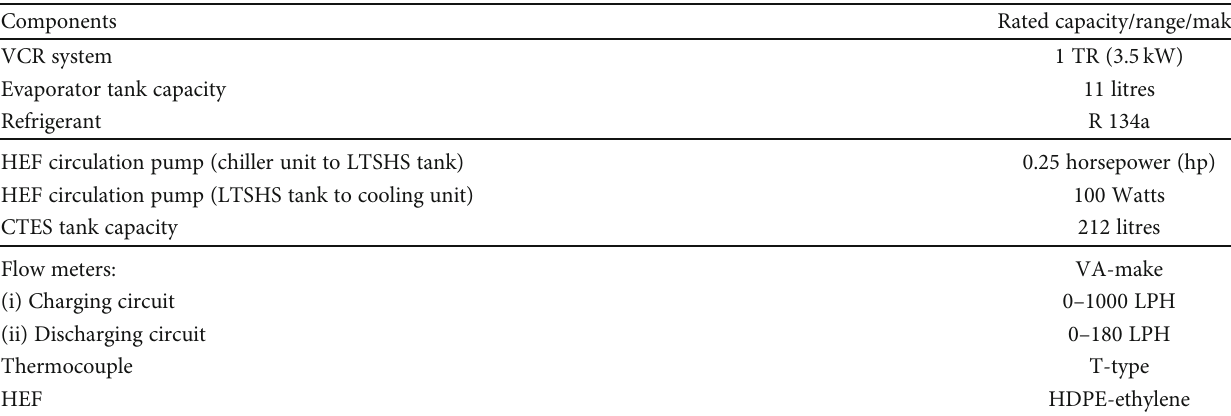
Table 1: Technical speci fi cations of system components.